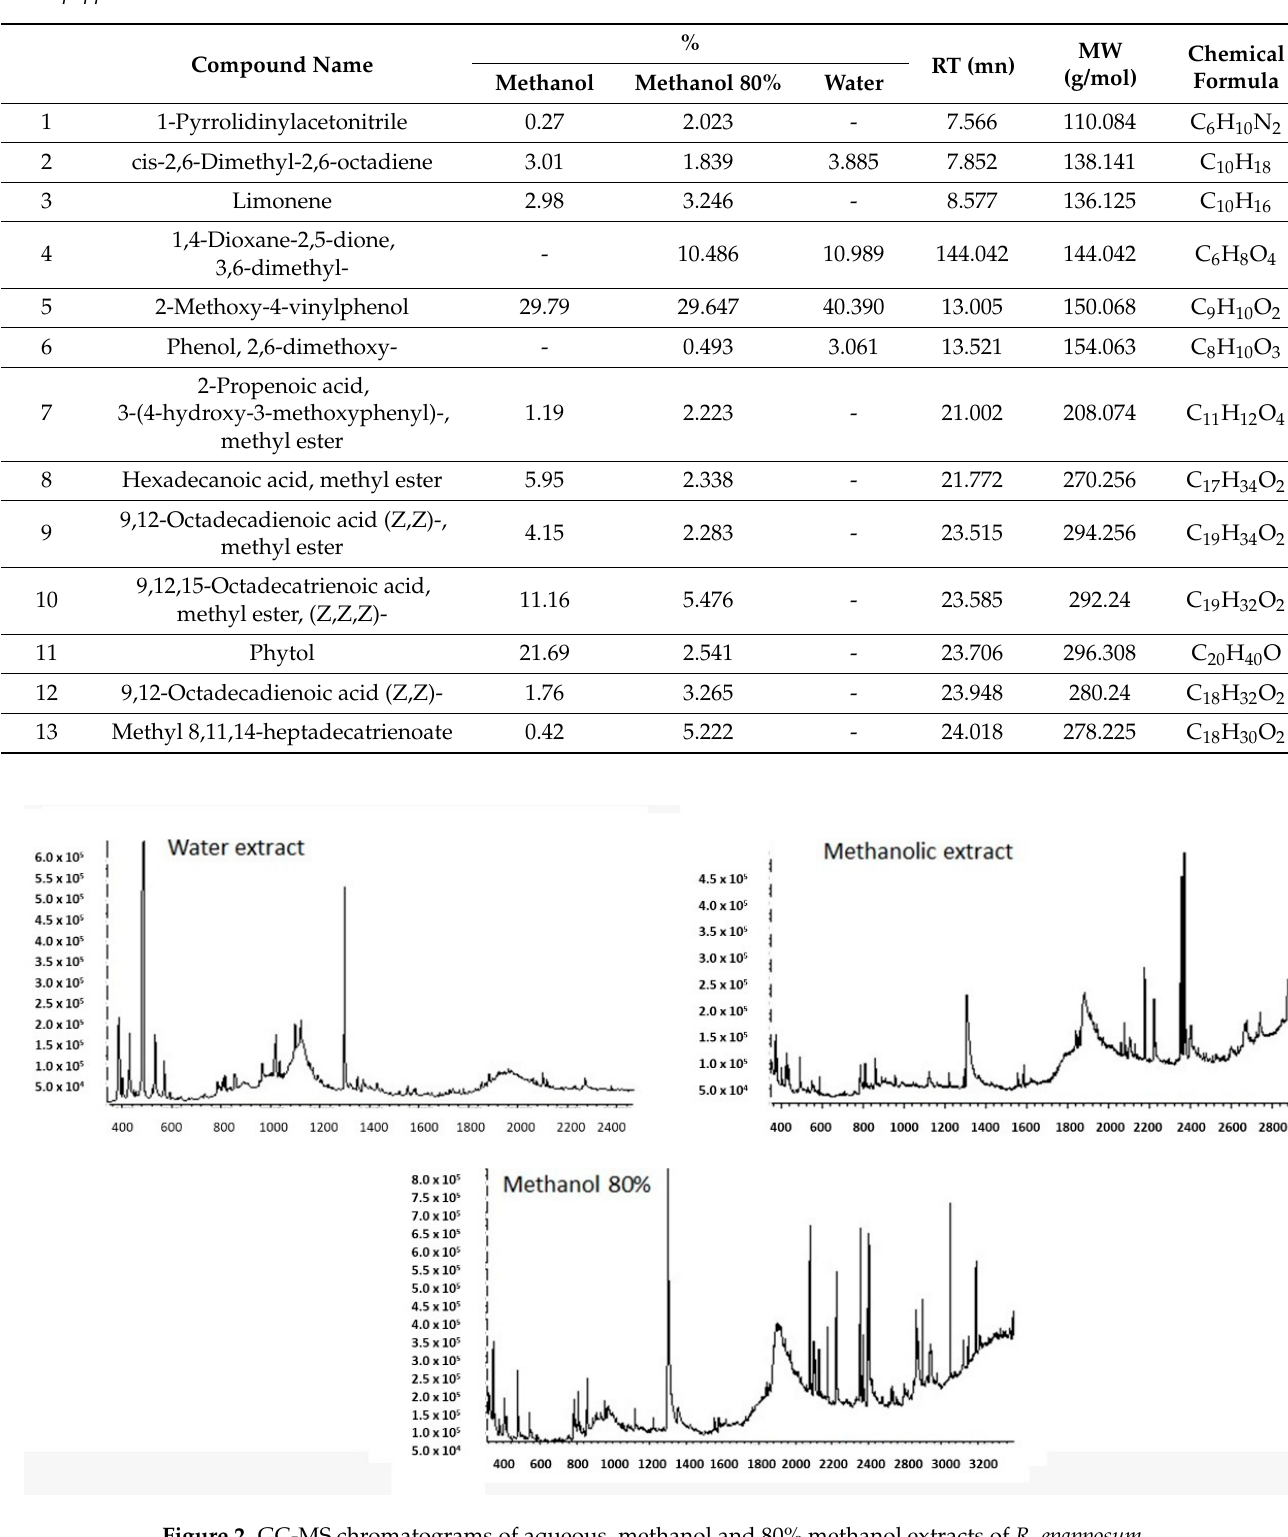
Table 4. Chemical composition of the compounds that are present in two or three methanolic, methanol 80%, and water R. epapposum extracts.